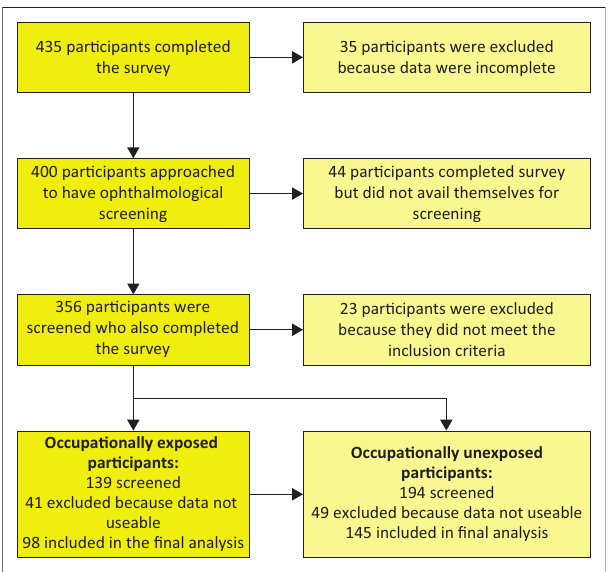
FIGURE 1: Illustration of the study population that were screened and completed the survey.